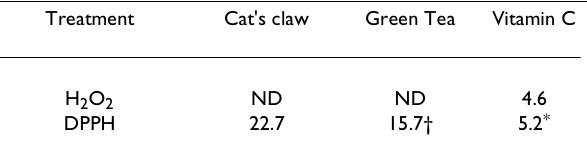
Table 5: Quenching of the DPPH Radical and H 2 O 2 by Dietary Antioxidants